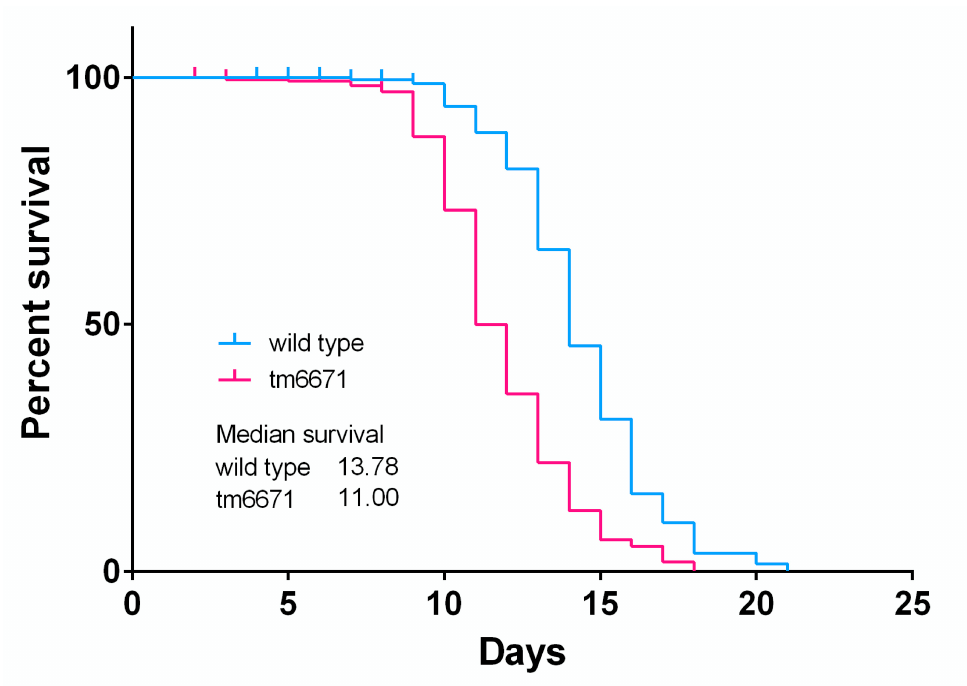
Figure 5. Kaplan–Meier survival curves of N2 and tm6671 mutant worms. Survival curves are shown for N2 and tm6671 mutant worms. The live/dead nematodes were scored every 24 h until all dead. Experimental conditions are described in Materials and Methods. The graph is representative of three independent biological replicates. Median lifespan, days: N2, 13.78; tm6671, 11.00. The log-rank test p -value for each experiment was < 0.001.